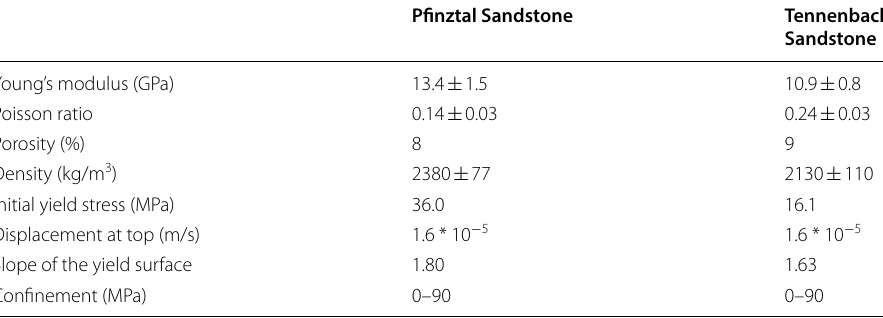
Table 3 Summary of the relevant data and uncertainty for PfSst and TenSst